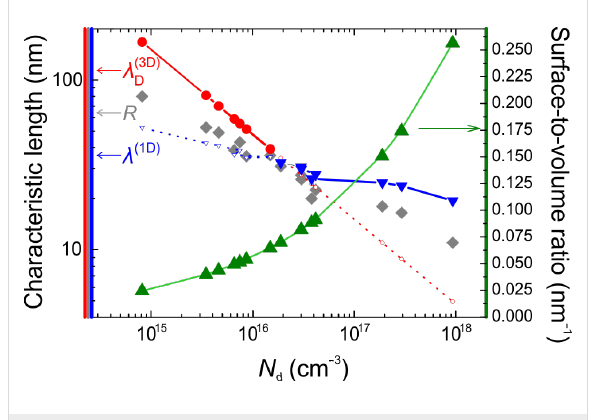
Figure 4: Characteristic length scales in Ge NWs. 3D Debye and 1D screening length λ (1D) as function of carrier density N d. NW radius sizes (grey symbols) are plotted as a reference. Green triangles show the corresponding surface-to-volume